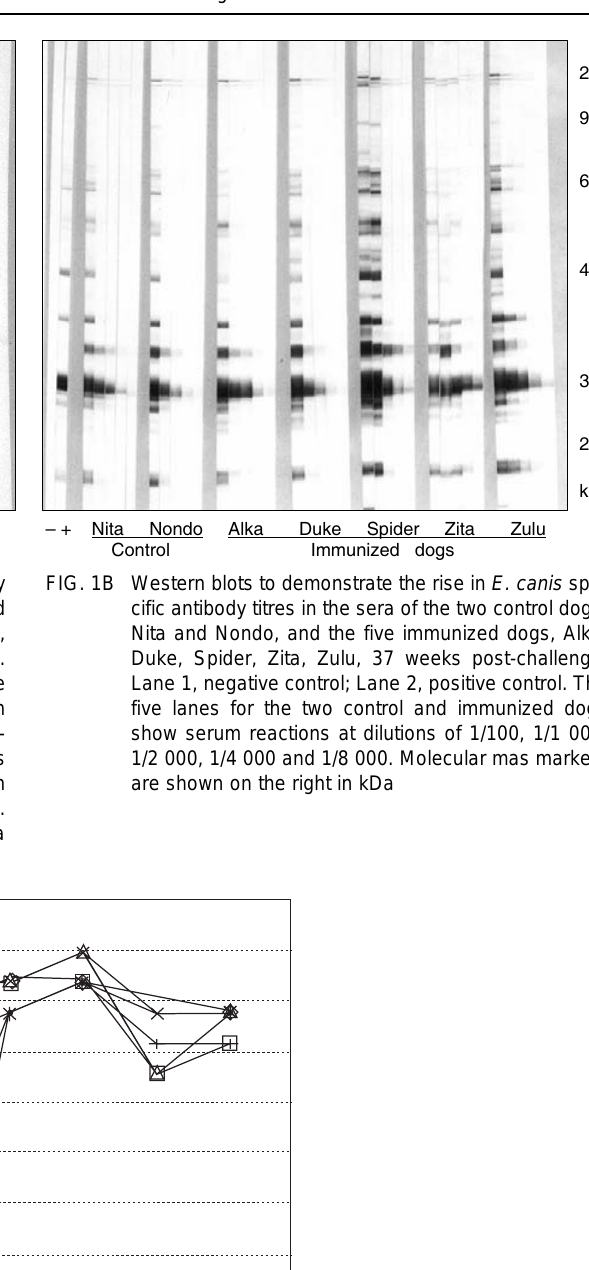
FIG. 2 Kinetics of antibody titres deter- mined by Western blots before and after immunization or chal- lenge with E. canis . Following immunization antibody titres increased and after challenge anamnestic and primary anti- body responses were detected in the immunized and control dogs,